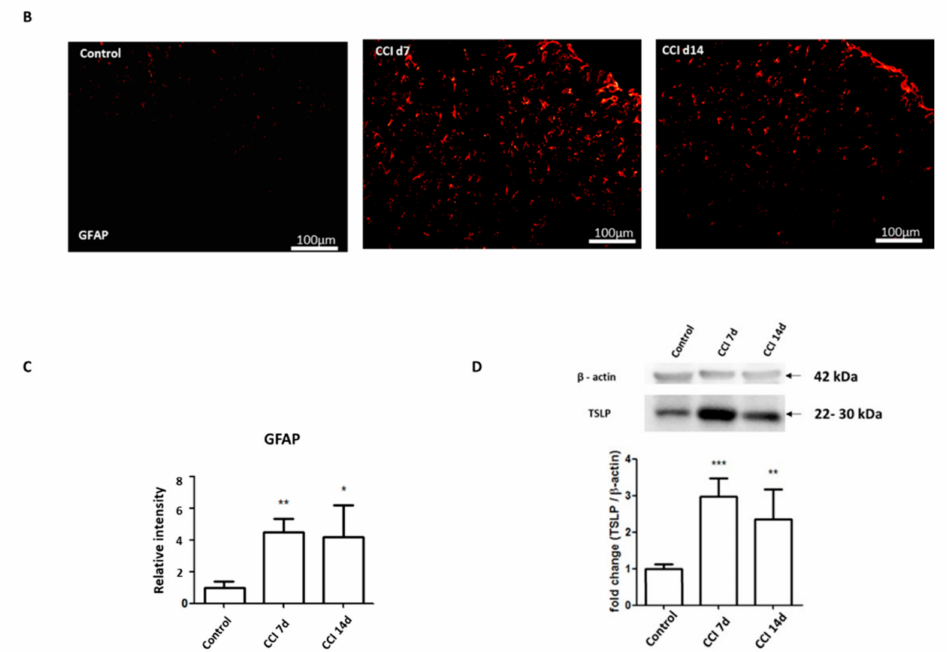
Figure 1. CCI induced mechanical allodynia and increased TSLP levels in L4/5 DRGs. ( A ) Behavioral data demonstrating the reduction of PWT though calibrated forceps test after CCI. The control group received no sciatic nerve ligation. N = 12 for each group. *** p < 0.001 vs. control group analyzed by ANOVA test. ( B ) Immunofluorescence staining showing increased astrocyte reaction in the L4/5 dorsal spinal cord of rats after CCI. Scale bar, 100 µ m. ( C ) Relative fluorescence intensity of GFAP. ( D ) Western blot analysis showing increased TSLP protein expression in L4/5 DRGs of rats after CCI. Each band density was quantitated, normalized with its own β -actin. Values are presented as mean ± SEM. N = 6 for each group. * p < 0.05, ** p < 0.01 and *** p < 0.001 vs. control group analyzed by ANOVA